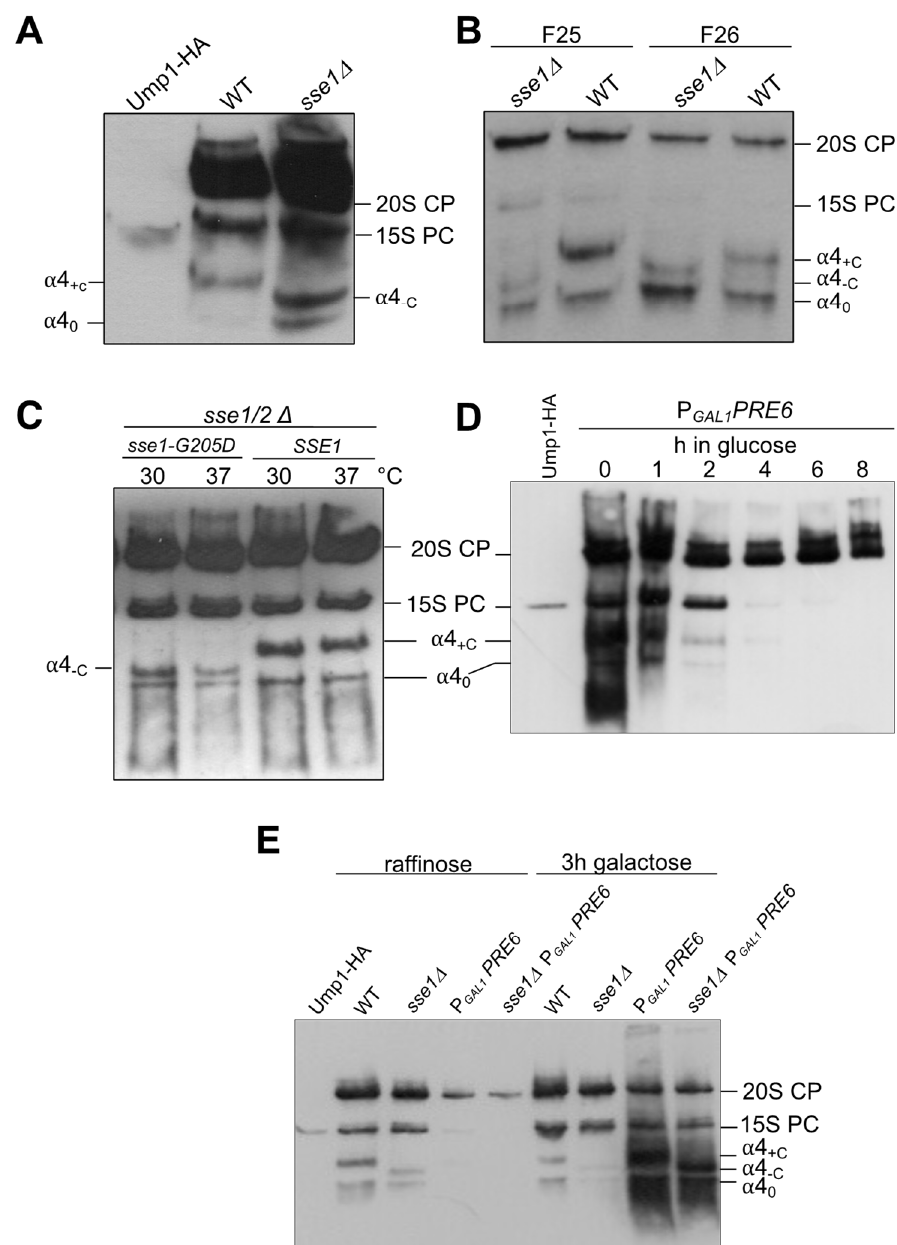
Figure 3 . Identification of three distinct small complexes containing α 4-HA by native PAGE and anti-HA immunoblotting. ( A ) Total protein extracts (8 μ g) from WT and sse1 ∆ strains expressing PRE6-HA (encoding α 4-HA) were compared by native PAGE analysis. ( B ) Fractions 25 and 26 from Superdex200 gel filtration of WT or sse1 ∆ protein extracts were analyzed by native PAGE. ( C ) α 4 complexes were compared in sse1 ∆ sse2 ∆ cells expressing either WT SSE1 or sse1-G205A , the latter encoding a mutant Sse1 protein with reduced ability to interact with Ssa1/2. The cells were grown at the indicated temperatures for 3 h. ( D ) Cells from a strain expressing PRE6-HA from P GAL1 were grown in media containing galactose until OD 600 of 0.6, washed and grown further in media containing glucose for the indicated times. ( E ) WT or sse1 ∆ cells expressing PRE6-HA from P GAL1 were grown in media containing raffinose until OD 600 of 0.6, and switched for 3 h to galactose media. α 4 α 4; α 4 α 4 lacking chaperone; α 4 0 , basal complex containing -C , complex containing +C , complex containing α 4 with chaperone. Strains used in this figure are derivatives of